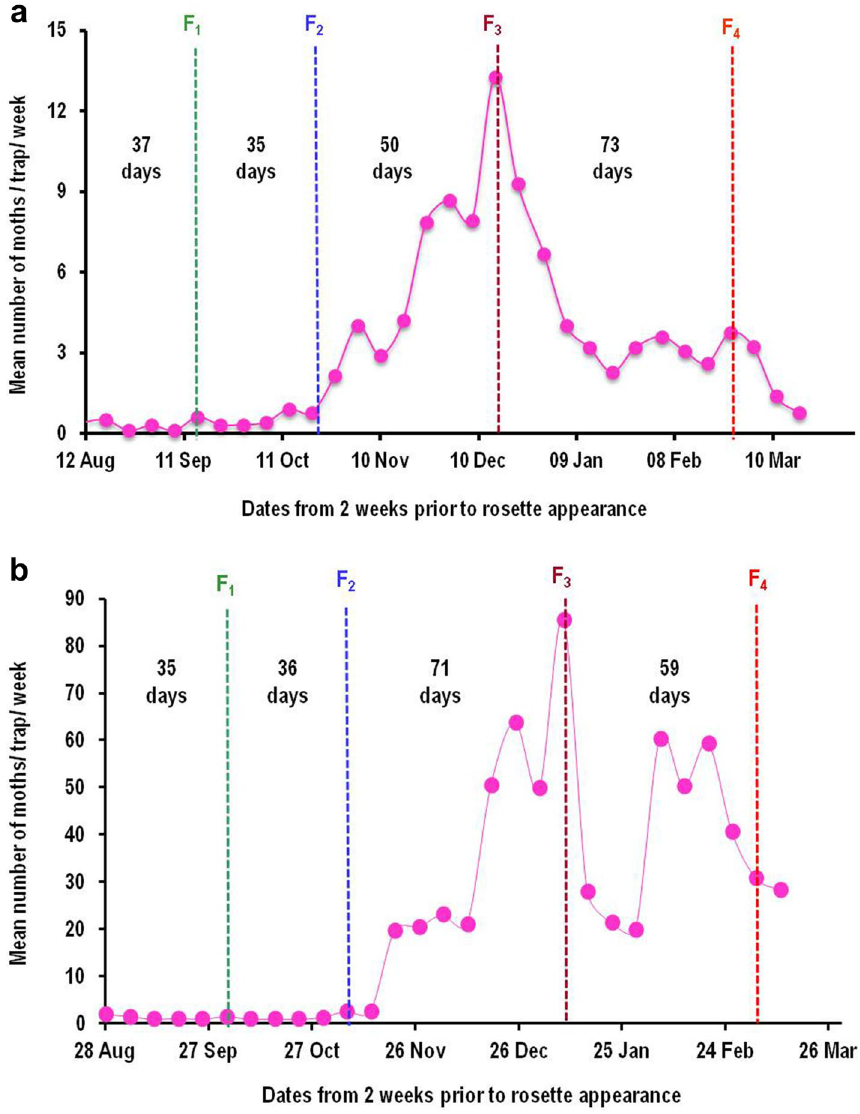
Figure 5. Generation events estimated for pink bollworm based on days lapsed between successive moth catch peaks recorded in sex pheromone traps at Nagpur (India). When moth catches were plotted against calendar dates, the number of days per generation varied between 35–73 during 2018–19 (Fig. 6a) and 35–71 during 2019–20 (Fig. 6b) in response to changes in daily minimum and maximum